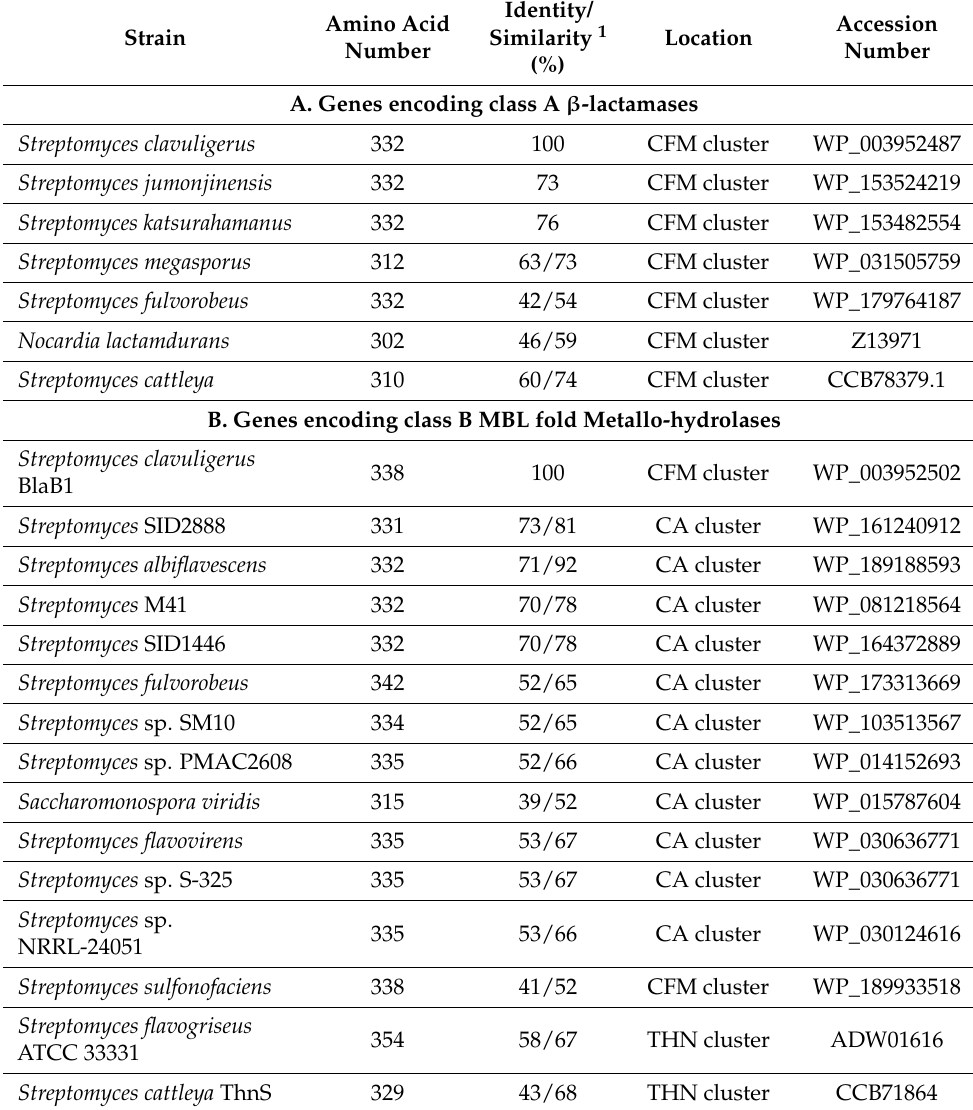
Table 3. Genes for β -lactamases located in actinobacteria β -lactam biosynthesis